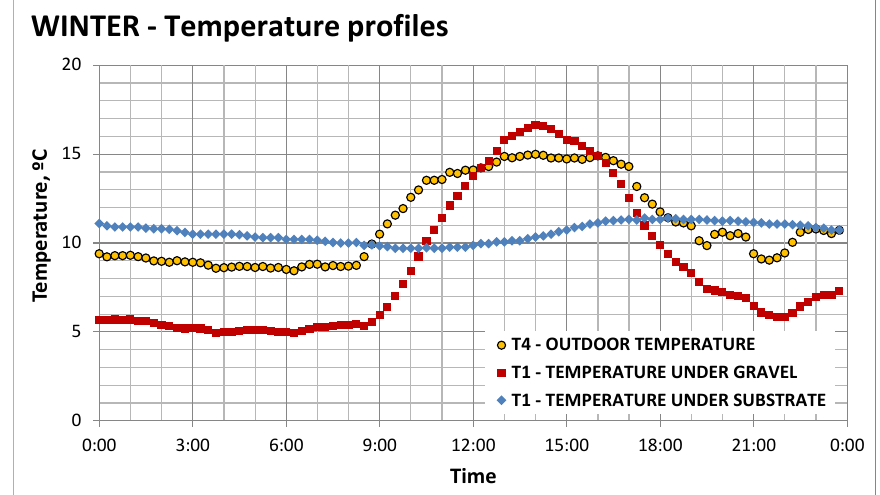
Figure 10. Temperatureevolution for a typical winter day with and w/o green roof.